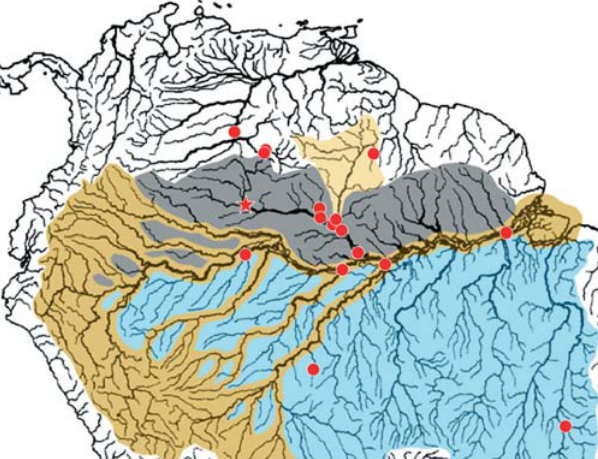
Fig. 9. Distribution of Leptodoras praelongus (star denotes type locality). Color overlays approximate water conditions as moderate to extreme blackwaters (gray), sediment-rich whitewaters (brown), mixed black/whitewaters (tan) and pre- dominantly clearwaters (blue). Drainage base map by